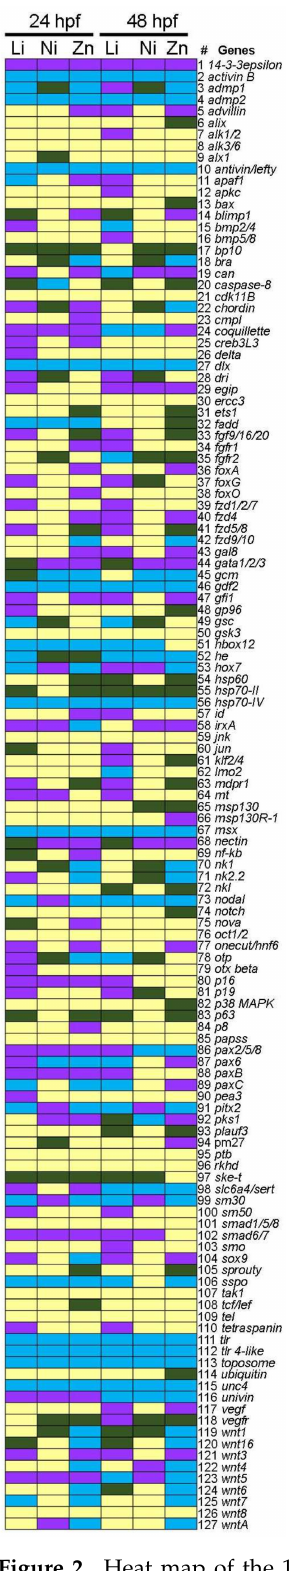
Figure 2. Heat map of the 127 genes analyzed following metal treatments. The heat map was generated using conditional formatting on Microsoft Excel. Genes are reported in alphabetical order. Violet, green, and light yellow indicate fold values < − 2, >+2 and between − 2 and +2, respectively; light blue indicates not quantifiable genes. Li, embryos treated with 30 mM LiCl; Ni, embryos treated with 0.5 mM NiCl 2 ; Zn, embryos treated with 0.1 mM ZnSO 4 . Hpf, hours